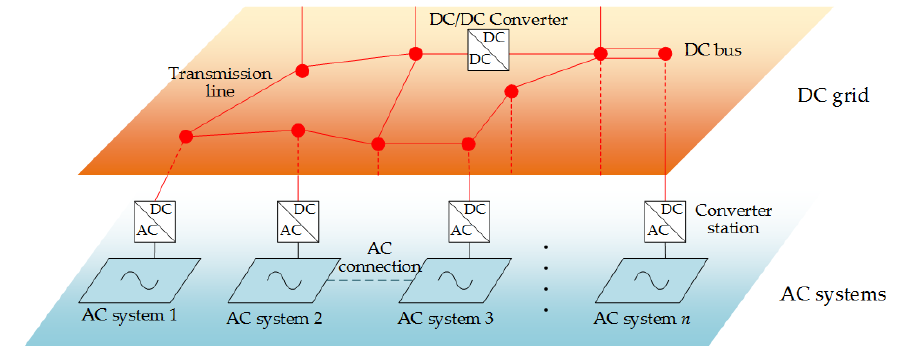
Figure 1. Schematic diagram of an HVDC grid.